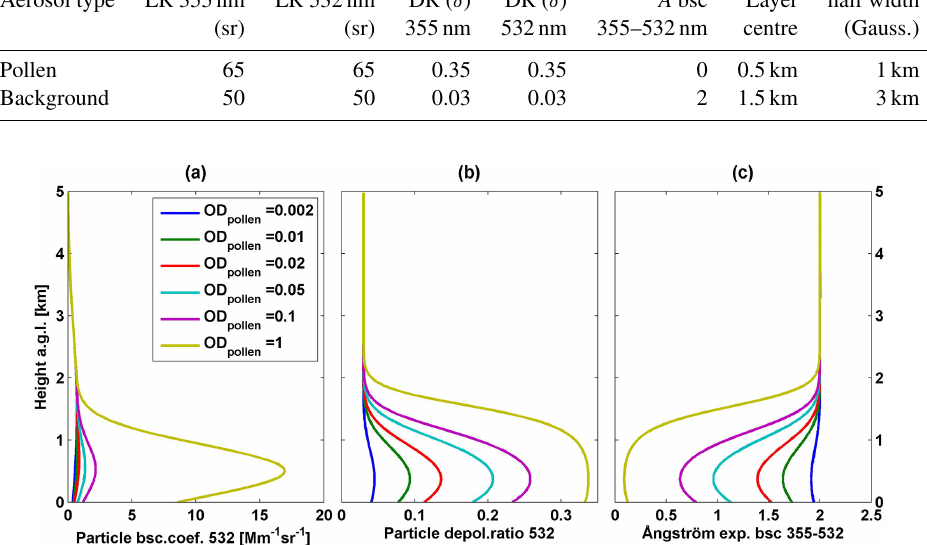
Figure 1. Six cases of simulated vertical profiles of (a) particle backscatter coefficient at 532nm, (b) particle linear depolarization ratio at 532nm, and (c) backscatter-related Ångström exponent between 355 and 532nm. Simulated results under different input pollen optical depth (OD) values are shown by